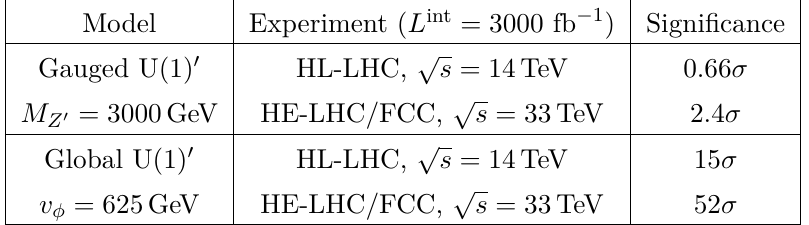
Table 4. Significances for the gg → φ → γγ signal with M φ = 340 GeV and the parameter setup given in equation (6.3) after the following cuts on both photons: | η | < 2 . 5 and p T > 25